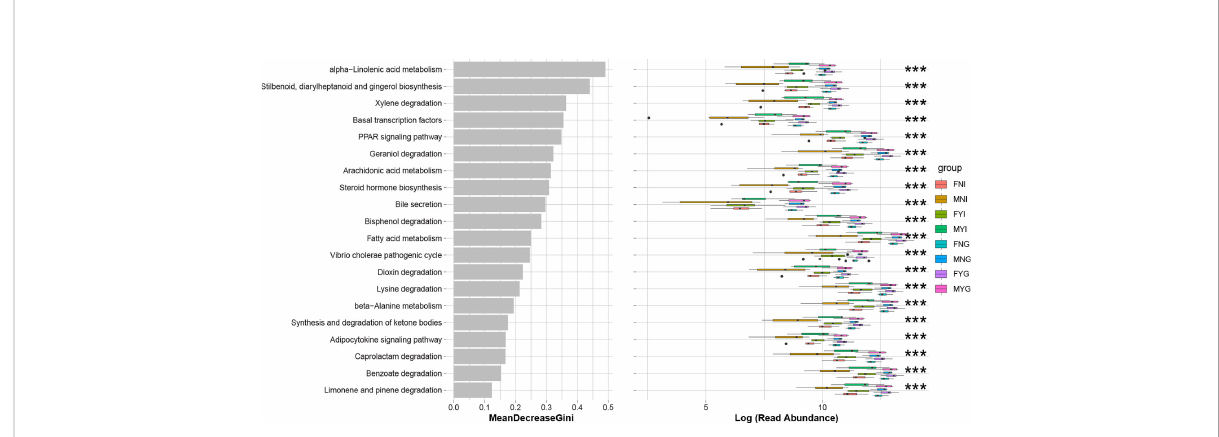
FIGURE 10 Prediction functions according to KEGG pathways in the bacterial communities of medium-form squid. *** indicates the signi fi cant difference between samples (p <